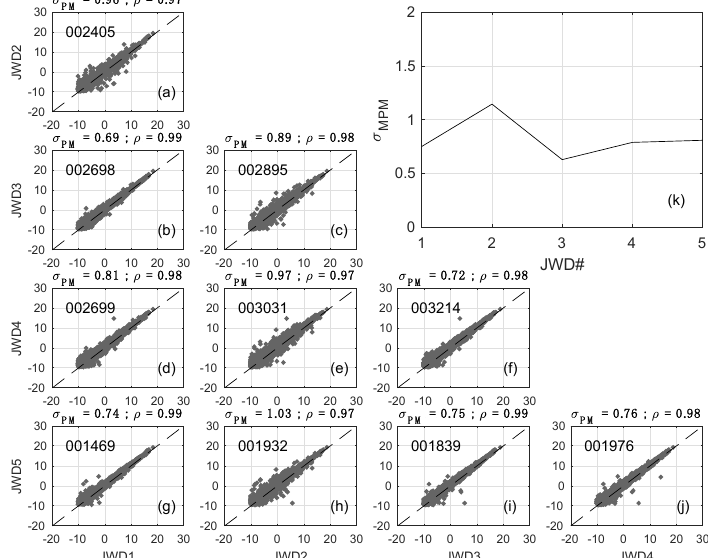
Figure 9. ( a )–( j ): scatterplot of rainfall rate (dBR) calculated from five JWD disdrometers. The corresponding values of the measurement error ( σ PM ) from paired measurements and the correlation coefficient ( ρ ) are shown on the top of each panel. The standard deviation of the measurement noise ( σ MPM ) from multiple paired measurements are shown in ( k ).